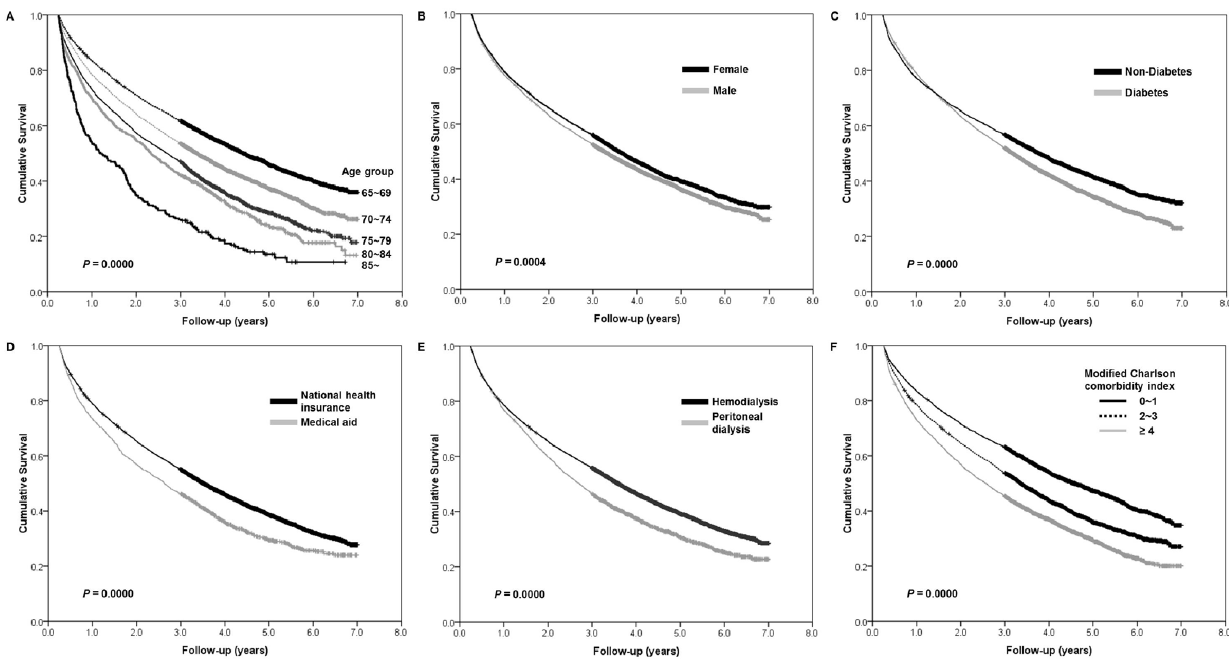
Figure 1. Kaplan-Meier survival curves and comparisons of survival rates by log-rank test. (A) Mortality rates gradually increased with the increment of age categories ( P= 0.0000). (B) Females showed better survival rate compared to males ( P= 0.0004). (C) Survival rate was better for patients without diabetes than that with diabetics ( P= 0.0000). (D) Patients covered by National Health Insurance experienced higher better survival rate compared to Medical Aid beneficiaries ( P= 0.0000). (E) Patients on hemodialysis experienced significant survival benefit over patients on peritoneal dialysis in the intention-to-treat analysis ( P= 0.0000). (F) As the modified Charlson comorbidity index for end-stage renal disease patients increased, survival rates significantly decreased ( P=